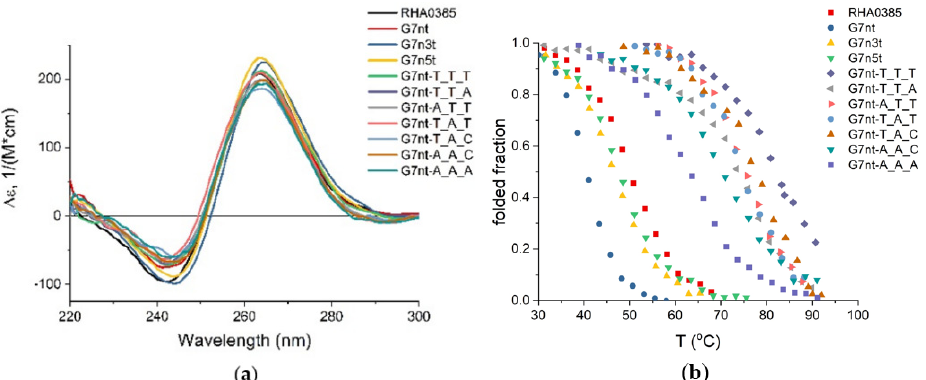
Figure 4. Circular dichroism spectroscopy of aptamers to HA: ( a ) CD spectra of RHA0385 and its variants obtained at the same conditions (20 °C, 2 µM solution in sodium-potassium phosphate buffer pH 7.4 in the presence of 10 mM K + ); ( b ) normalized curves of the CD melting of RHA0385 and its variants.